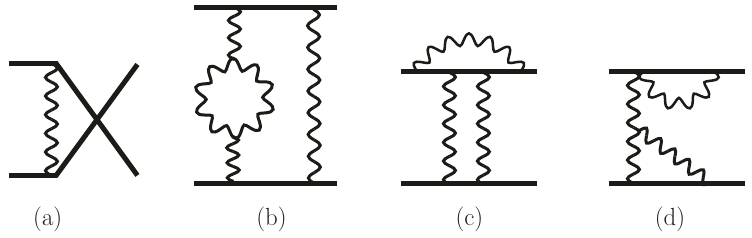
Figure 3 . Examples of one- and two-loop diagrams that do not contribute to the classical potential. Wiggly lines represent gravitons and straight lines scalars. The meaning of diagrams here is the same as in (cid:12)gure